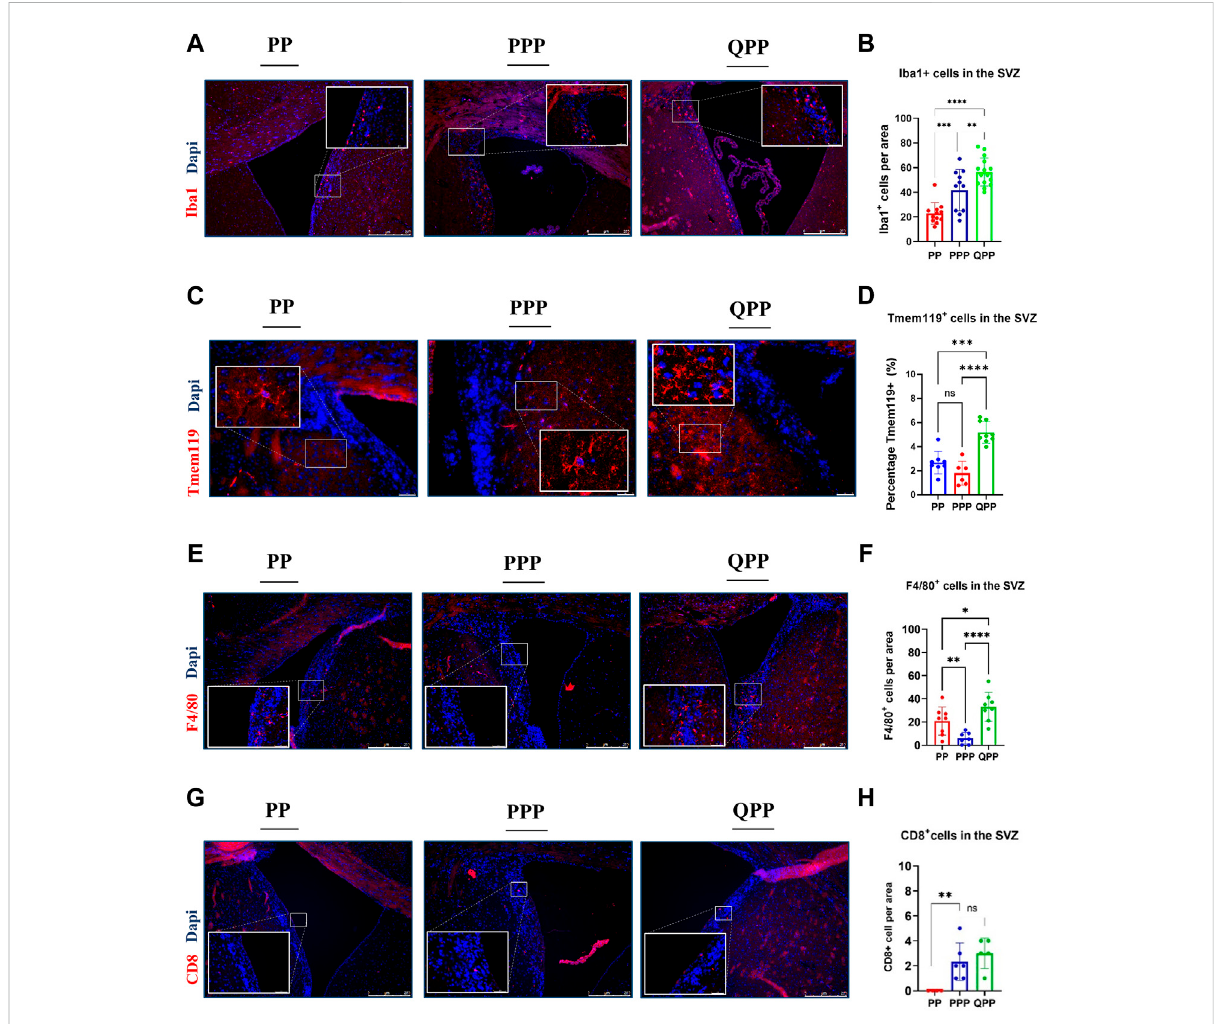
FIGURE 2 Early premalignant lesions of the QPP mice demonstrated a tumor-permissive microenvironment compared to those of the PP and PPP mice (A) . Immuno fl uorescence staining images of IBA1-positive myeloid cells in the SVZ regions of PP, PPP, and QPP brains, respectively. Scale bars represent 250 μ m. (B) . Quanti fi cation and comparison of IBA1-positive myeloid cell numbers between PP, PPP, and QPP premalignant SVZ regions. (C) .Immuno fl uorescencestainingimagesofTMEM119-positivemicrogliaintheSVZregionsofPP,PPP,andQPPbrains,respectively.Scalebars represent 50 μ m. (D) . Quanti fi cation and comparison of TMEM119-positive area percentages between PP, PPP, and QPP premalignant SVZ regions. (E) . Immuno fl uorescence staining images of F4/80-positive macrophages in the SVZ regions of PP, PPP, and QPP brains, respectively. Scale bars represent 250 μ m. (F) . Quanti fi cation and comparison of F4/80-positive macrophage numbers between PP, PPP, and QPP premalignant SVZ regions. (G) . Immuno fl uorescence staining images of CD8-positive lymphocytes in the SVZ regions of PP, PPP, and QPP brains, respectively. Scale bars represent 250 μ m. (H) . Quanti fi cation and comparison of CD8-positive lymphocyte numbers between PP, PPP, and QPP premalignant SVZ regions. (Two-way ANOVA, ns = not signi fi cant, * = p < 0.05, ** = p < 0.01, *** = p < 0.001, and **** = p <